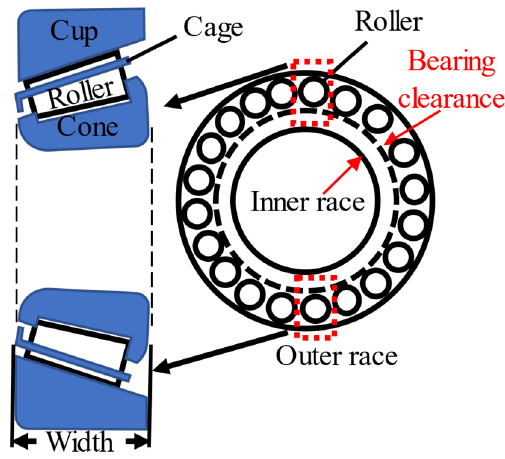
Figure 2. Bearing with clearance